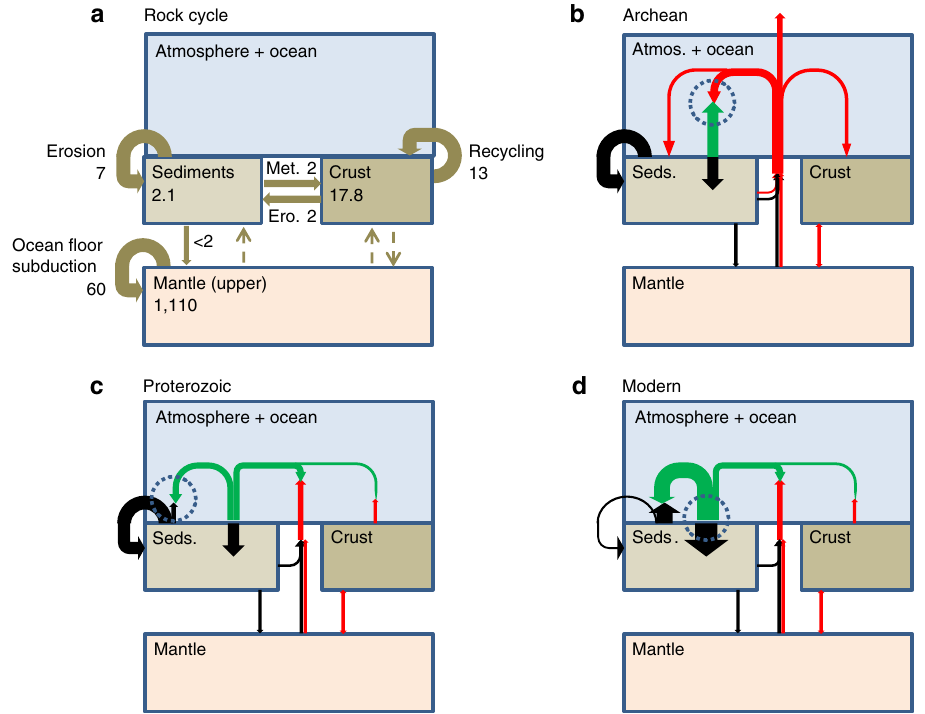
Figure 1 | Schematic of the rock cycle and the evolution of controls on atmospheric oxygen. Arrows show fluxes of rock (brown), organic carbon (black), oxygen (green), and other reduced species (red). Dashed circle shows primary negative feedback control on atmospheric oxygen. ( a ) Modern rock cycle 36 fluxes (10 18 tonGyr (cid:2) 1 , ‘Met.’ ¼ metamorphism, ‘Ero.’ ¼ erosion) and masses (10 18 ton). ( b ) Archean: organic carbon burial is balanced by metamorphism, with negligible oxidative weathering. Atmospheric oxygen is a minor component with concentration determined by the oxygen sensitivity of reactions with reduced atmospheric gases. ( c ) Proterozoic: sedimentary organic carbon is partly oxidized but mainly recycled. Atmospheric oxygen is controlled by the oxygen sensitivity of oxidative weathering. ( d ) Modern: sedimentary organic carbon is oxidized with little recycling. Atmospheric oxygen is controlled by feedbacks on carbon